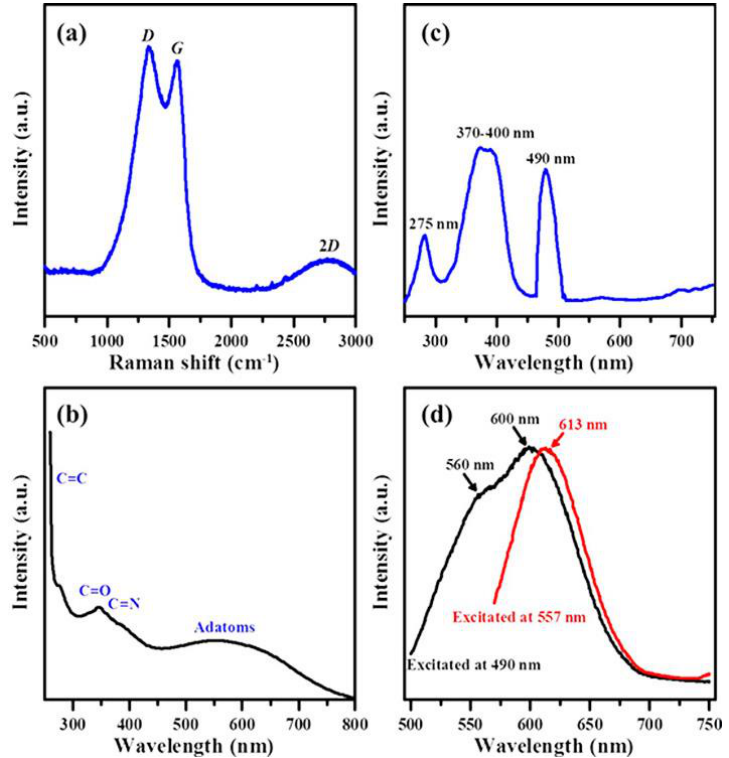
Figure 3. ( a ) Raman spectra of PEG 6000 /CD sample measured with 514 nm argon laser at 10 mW power, ( b ) UV-vis absorbance spectrum and ( c ) Photoluminescence (PL) excitation and ( d ) PL emission spectra